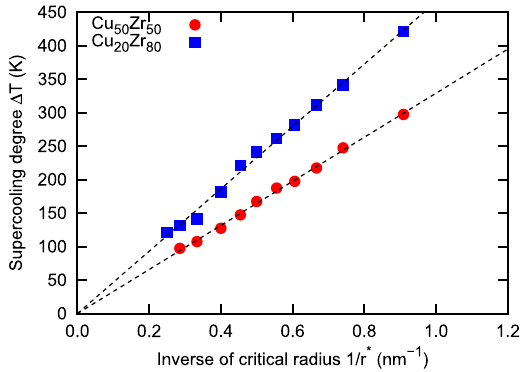
Figure 2. The relationship between supercooling degree Δ T and inverse of the critical radius 1/ r * .